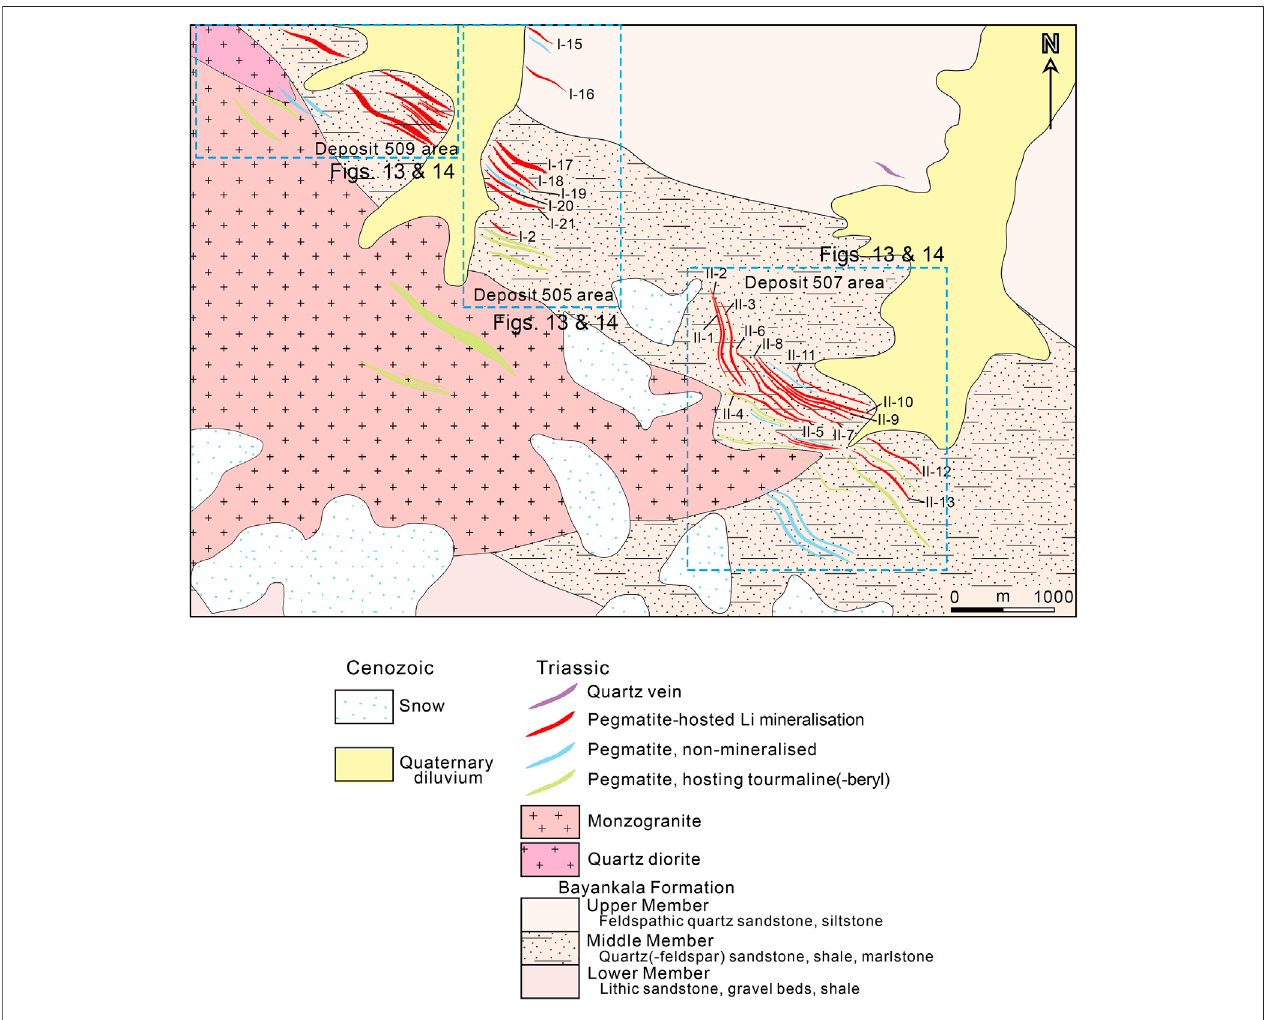
FIGURE 7 | Geological maps of the 505 Li deposit and 507 Li